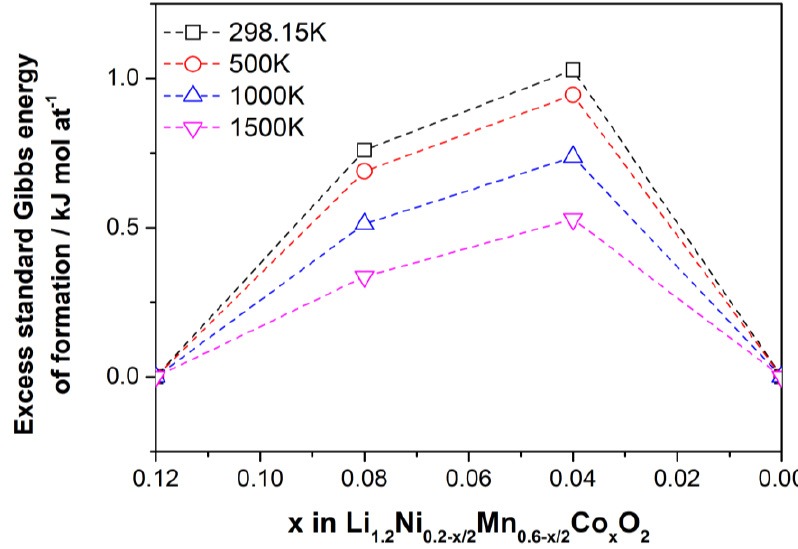
) at 298, 500, 1000, 1500 K for the intermediate LNMCx Figure 6. ∆ 𝑒𝑥𝑐𝑒𝑠𝑠 𝐺 𝑇𝑜 ( 𝑗 𝑥